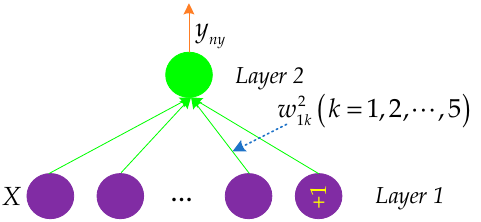
Figure 6. The structure of deep neural network used in the guidance subsystem.